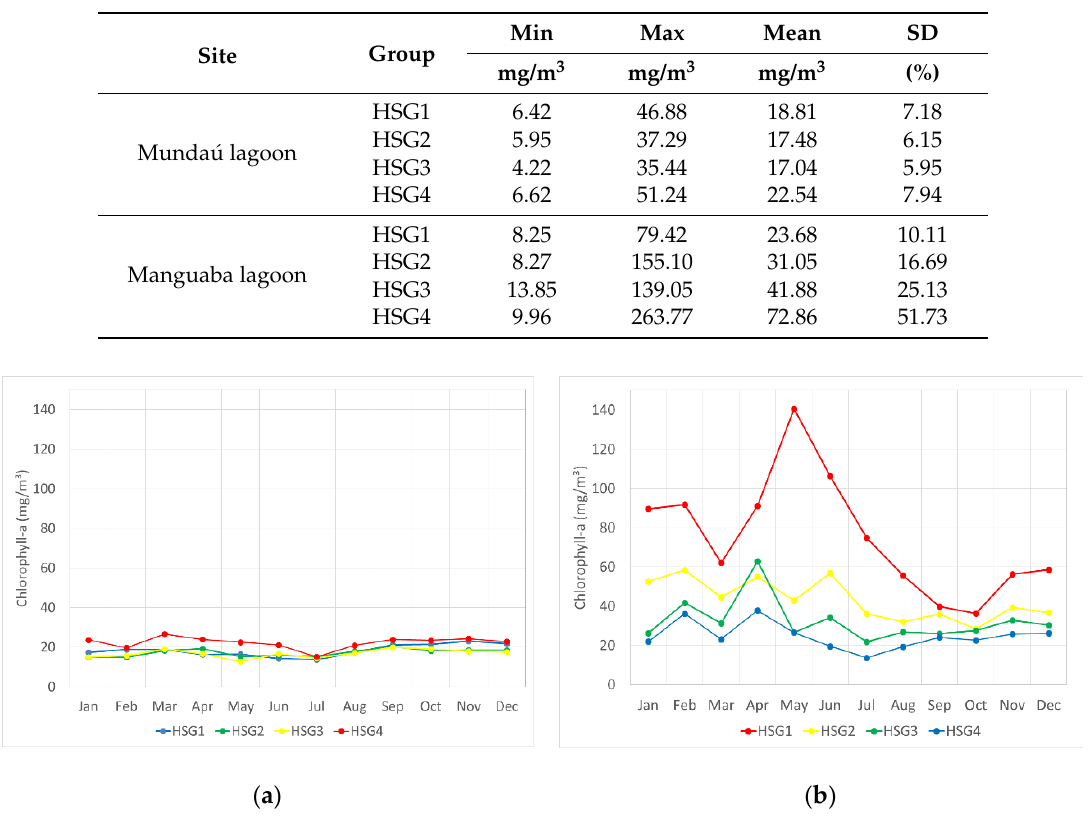
Figure 4. Homogeneous Spatial Groups (HSG) identified by Cluster Analysis using the first four principal rotated components from PCA in the ( a ) Mundaú and ( b ) Manguaba lagoons. Table 5. Statistics of estimated Chl-a considering different HSG for each lagoon.